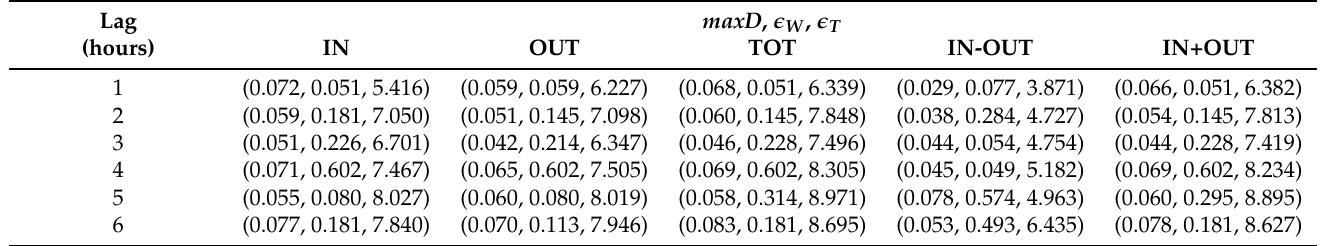
Tables 5, S41 and S42 give the χ 2 statistics C for the exact traffic counts, their variances,